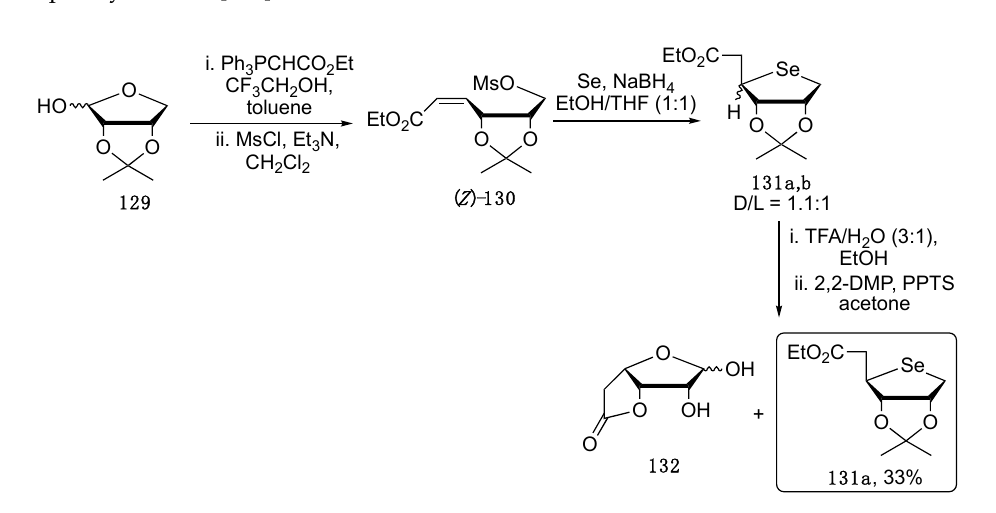
Scheme 22. Synthetic pathway to obtain the key selenosugar intermediate